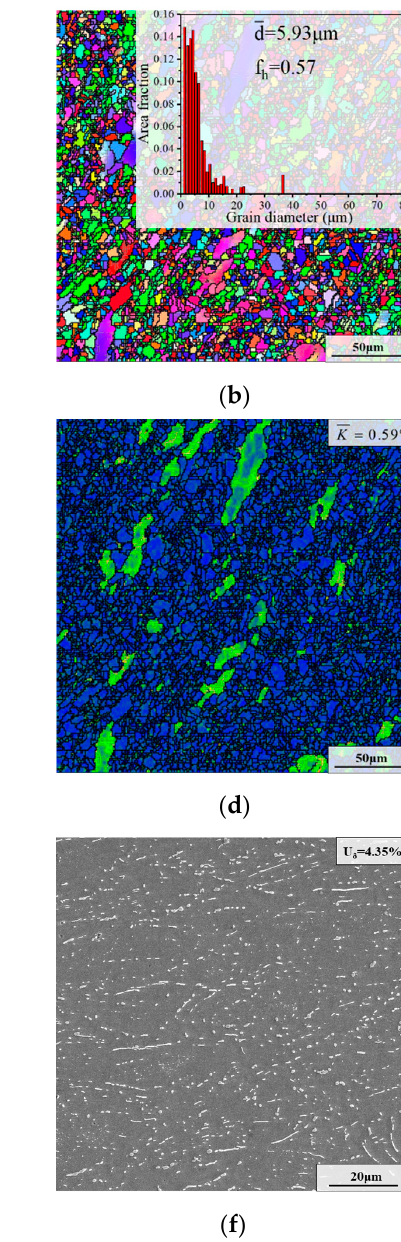
( f ) Figure 11. Microstructures after the second annealing stage with various strain rates of: ( a , c , e ) 0.001 s − 1 ; ( b , d , f ) 0.01 s − 1 . (The deformation temperature was 950 °C, and the true strain was 0.69. S 15–30 represents the cumulative value of the area fraction of average grain size in the range of 15–30 μ m). 3.3.3. Effect of True Strain Figure 12 depicts the microstructure after the second annealing stage with different